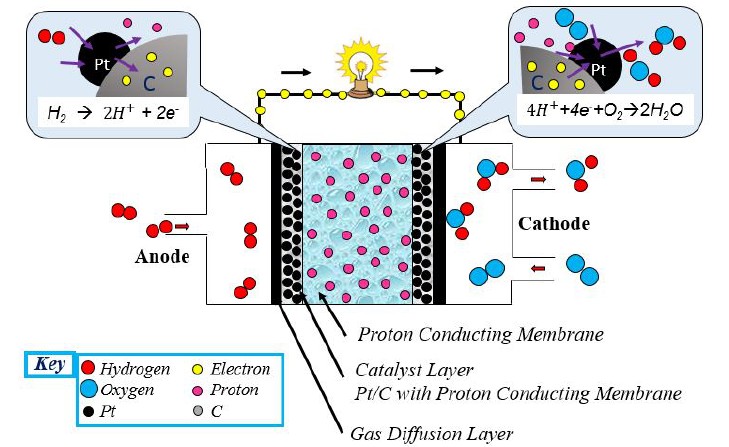
Figure 1. Fuel cell operation